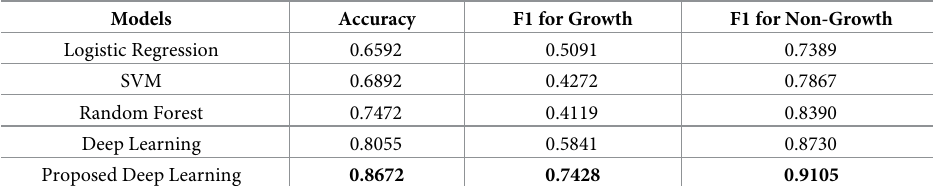
Table 1. Performance of prediction